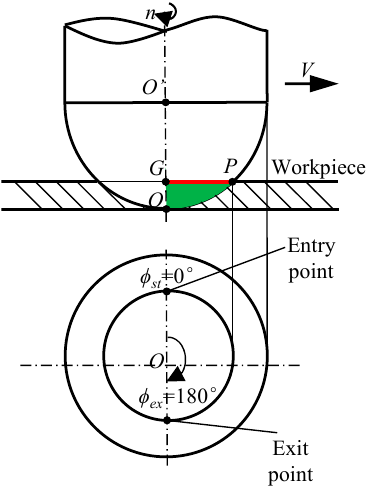
Figure 3. Cutting axis vertical to the workpiece surface.